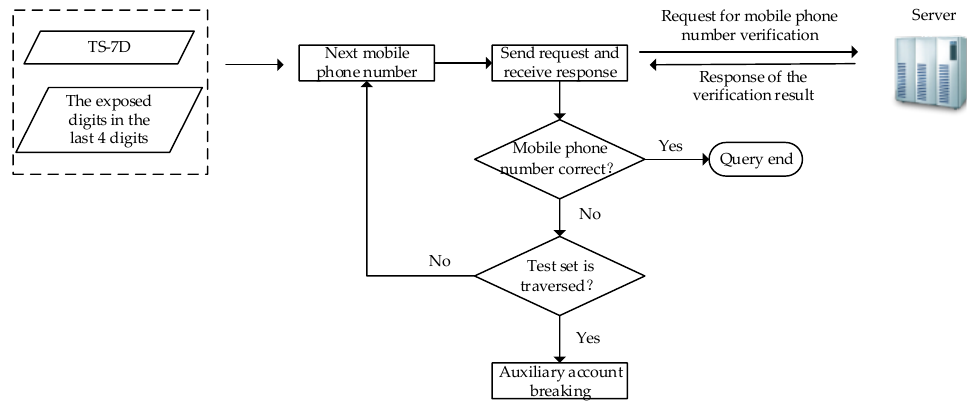
Figure 4. The process of breaking a user’s mobile phone number.